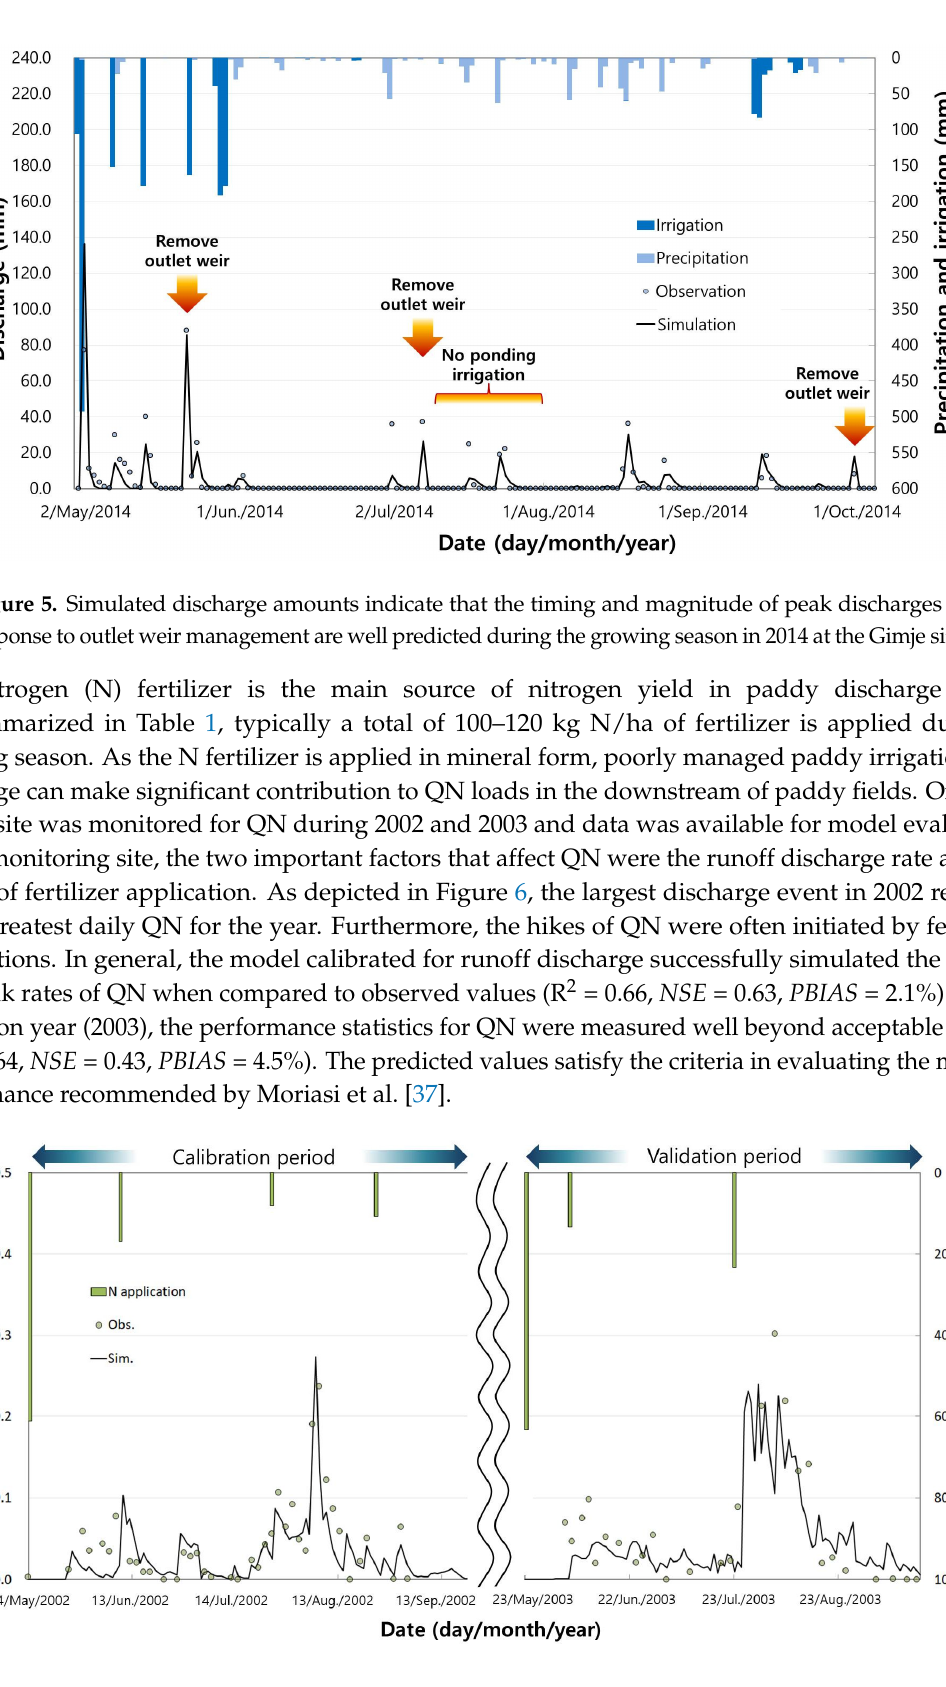
Figure 6. Daily QN predicted by APEX-Paddy is calibrated for the growing season in 2002 and then validated in 2003 at the Icheon site.